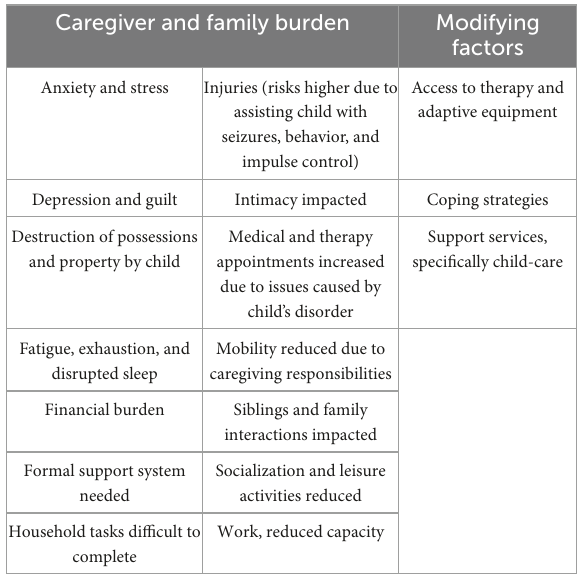
TABLE 3 Caregiver impacts of SLC6A1-related neurodevelopmental